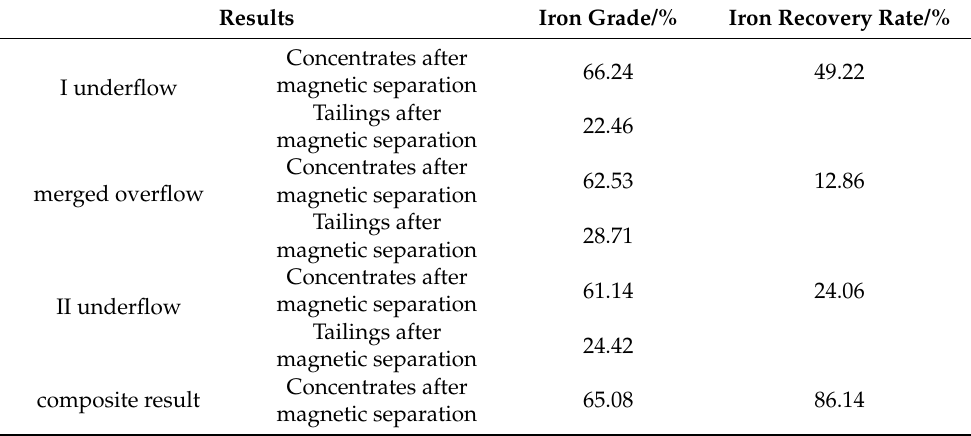
Figure 24. Four product hydrocyclone testing site. Table 4. Industries operating results.